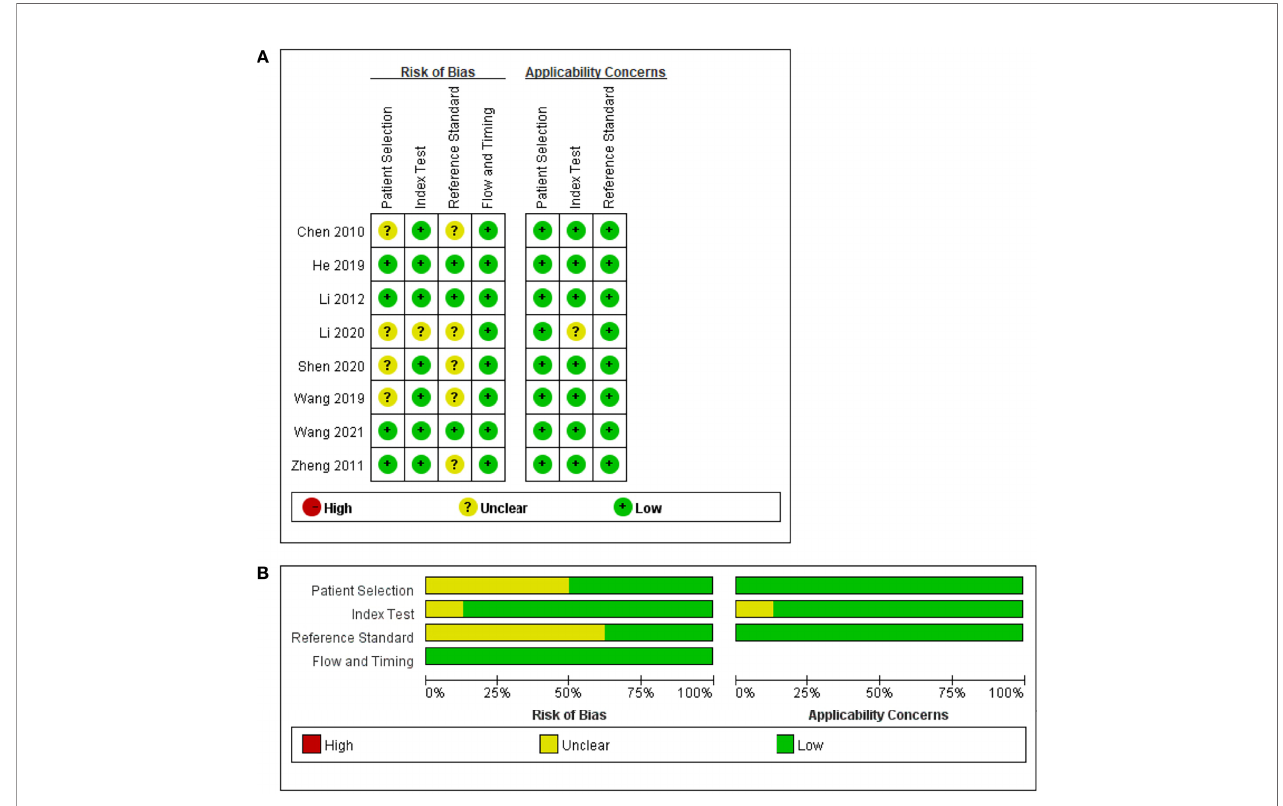
FIGURE 2 | Risk of bias and applicability concerns. (A) Summary: review authors ’ judgments about each domain for each included study. (B) Review authors ’ judgments about each domain presented as percentages across the included studies.